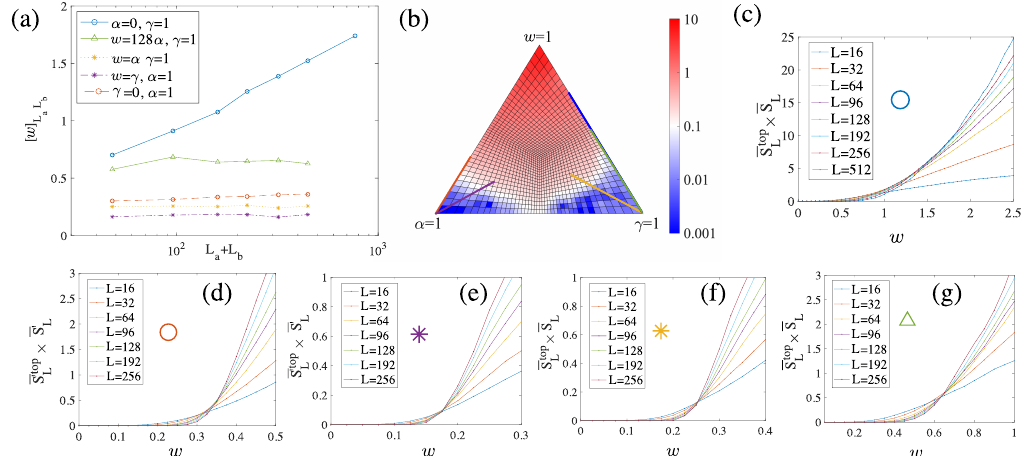
+ L as a function of L . (b) L a , L b a b